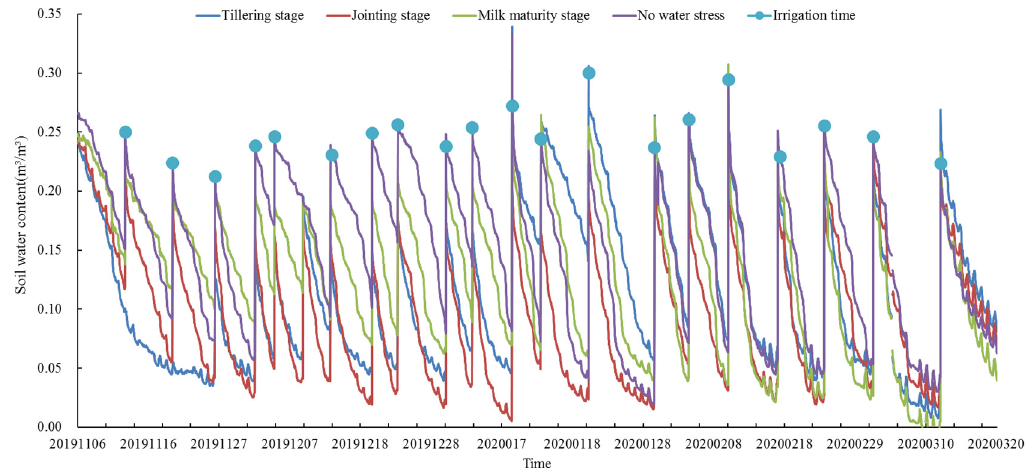
Figure 2. Soil water content variation for continuous observation (Date format: yyyymmdd).